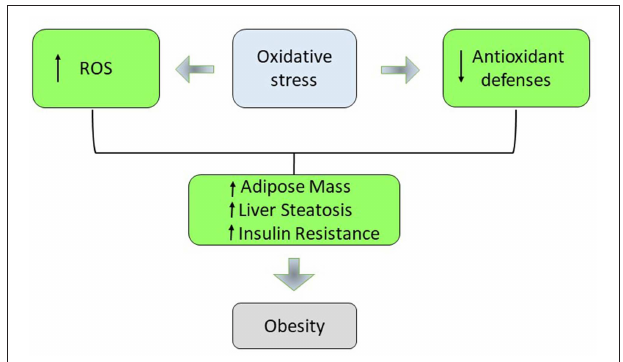
FIGURE 2 | The role of oxidative stress in